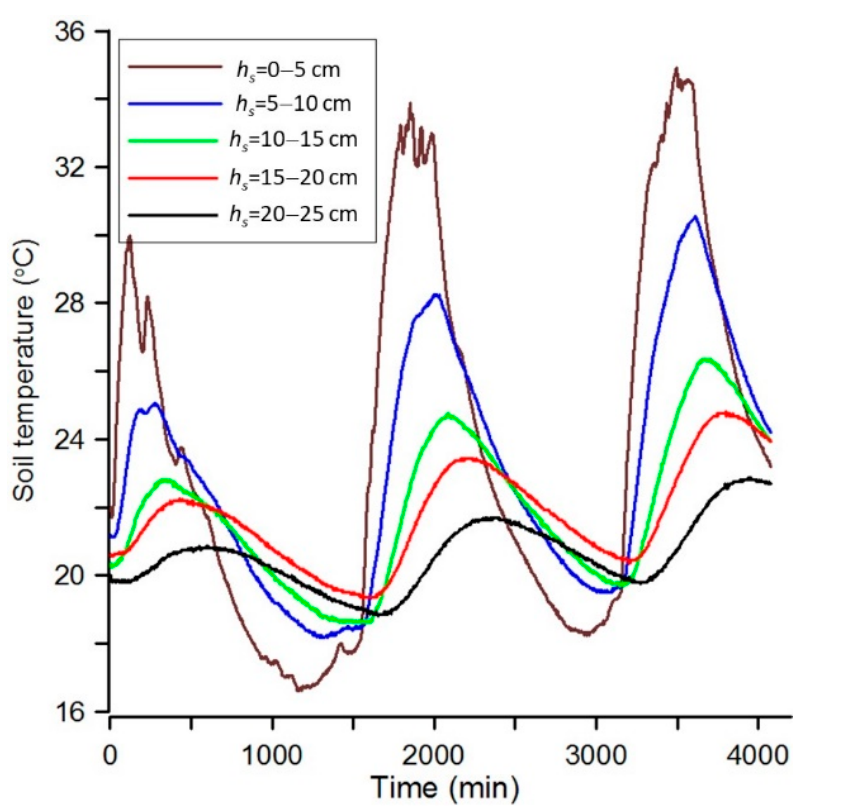
Figure 8. Dynamics of soil temperature variation at different depths observed in field conditions.